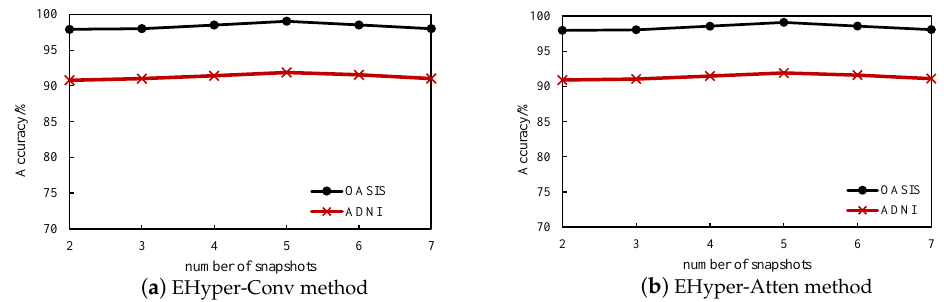
Figure 5. The effect of different number of snapshots in two methods. λ in Equation (3): In the process of the construction of the dynamic hyperbrain network, a brain region can interact with several other brain regions, and a set of hyperedges is produced through the changes in λ for each brain region. Among them, a large value means that the network is sparser and the nodes contained in the hyperedges are fewer. Therefore, we use different values λ = { 0.1, 0.2, 0.3, 0.4, 0.5, 0.6, 0.7, 0.8, 0.9 } to conduct experiments to explore their impact on the diagnosis results. The classification results are shown in Figure 6. It can be seen that the accuracy is improved gradually with the increase in λ value.